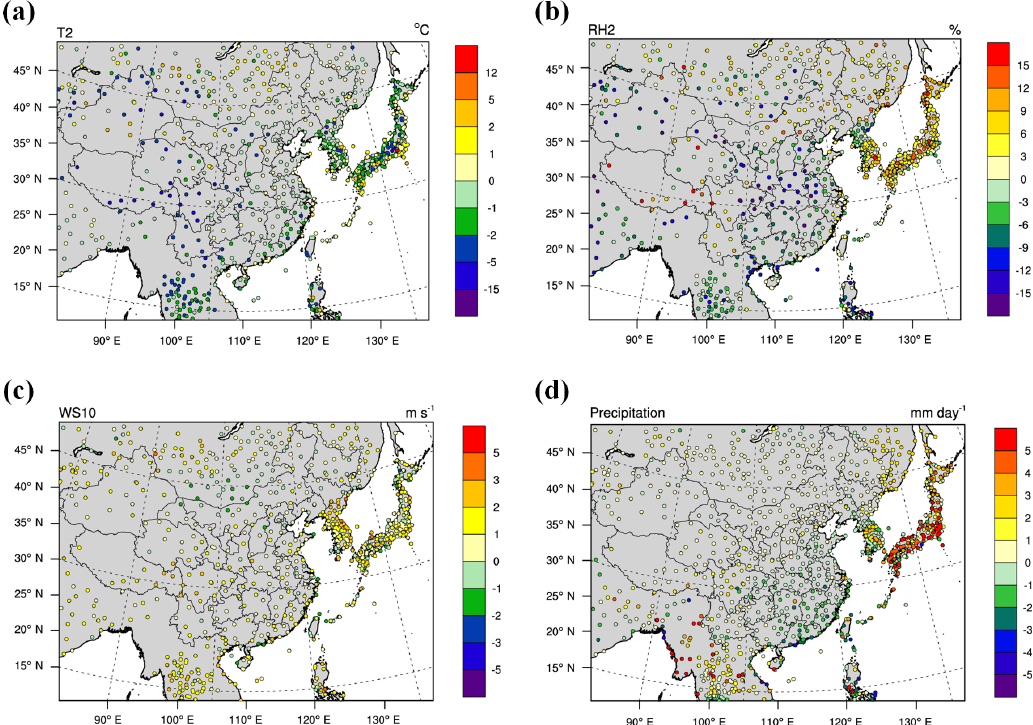
Figure 3. Spatial distribution of MBs for (a) 2m temperature (T2), (b) 2m relative humidity (RH2), (c) 10m wind speed (WS10), and (d) precipitation from NCDC under the climatological application during 2006–2010. Each marker represents the MB of each variable at each observational